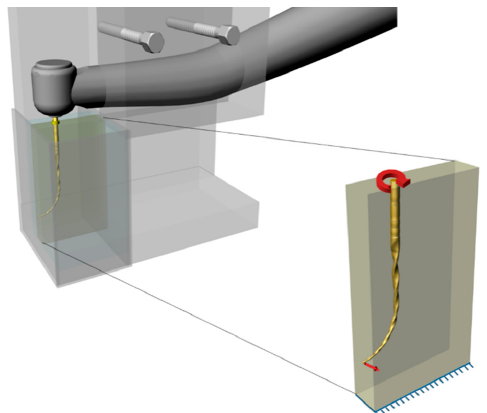
Figure 3. 3D model simulating the in vitro curved canal used for laboratorial studies. Two different loading conditions were considered at the same time: the reaction force (bending) during the instrument insertion (small red arrow) and the torque (large red arrow). Individual canals were modeled according to the instruments conicity and shape, in order to standardize the interaction with the canal